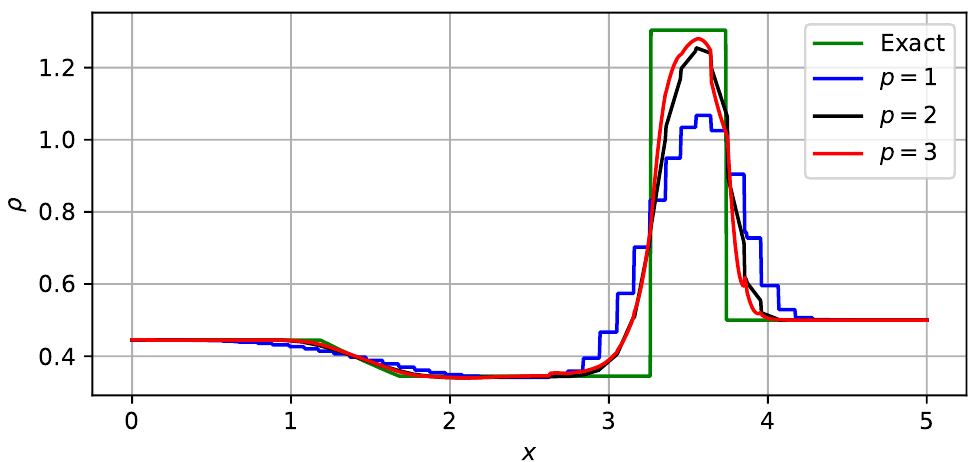
Figure 16. Comparison between solutions of ρ ( t = 1.0 ) in Problem 3.